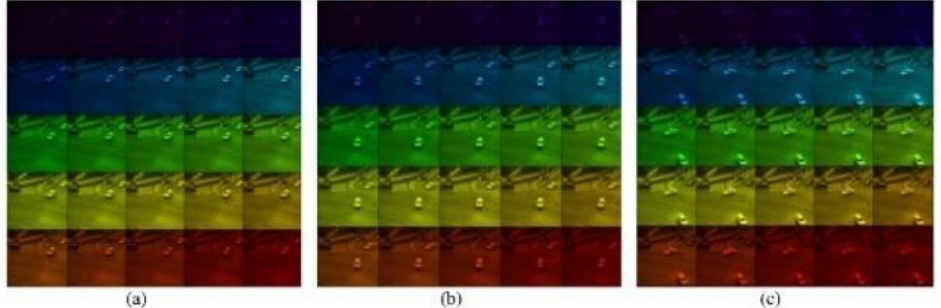
Figure 40. Image results of a dynamic scene. ( a ) The first-, ( b ) second-, and ( c ) third-snapshot spectral images extracted from video 1.